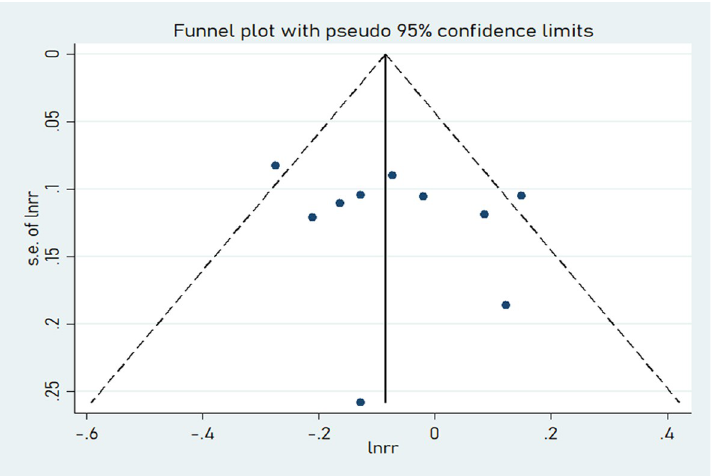
Fig 7. Funnel plot for the association between GL and lung cancer